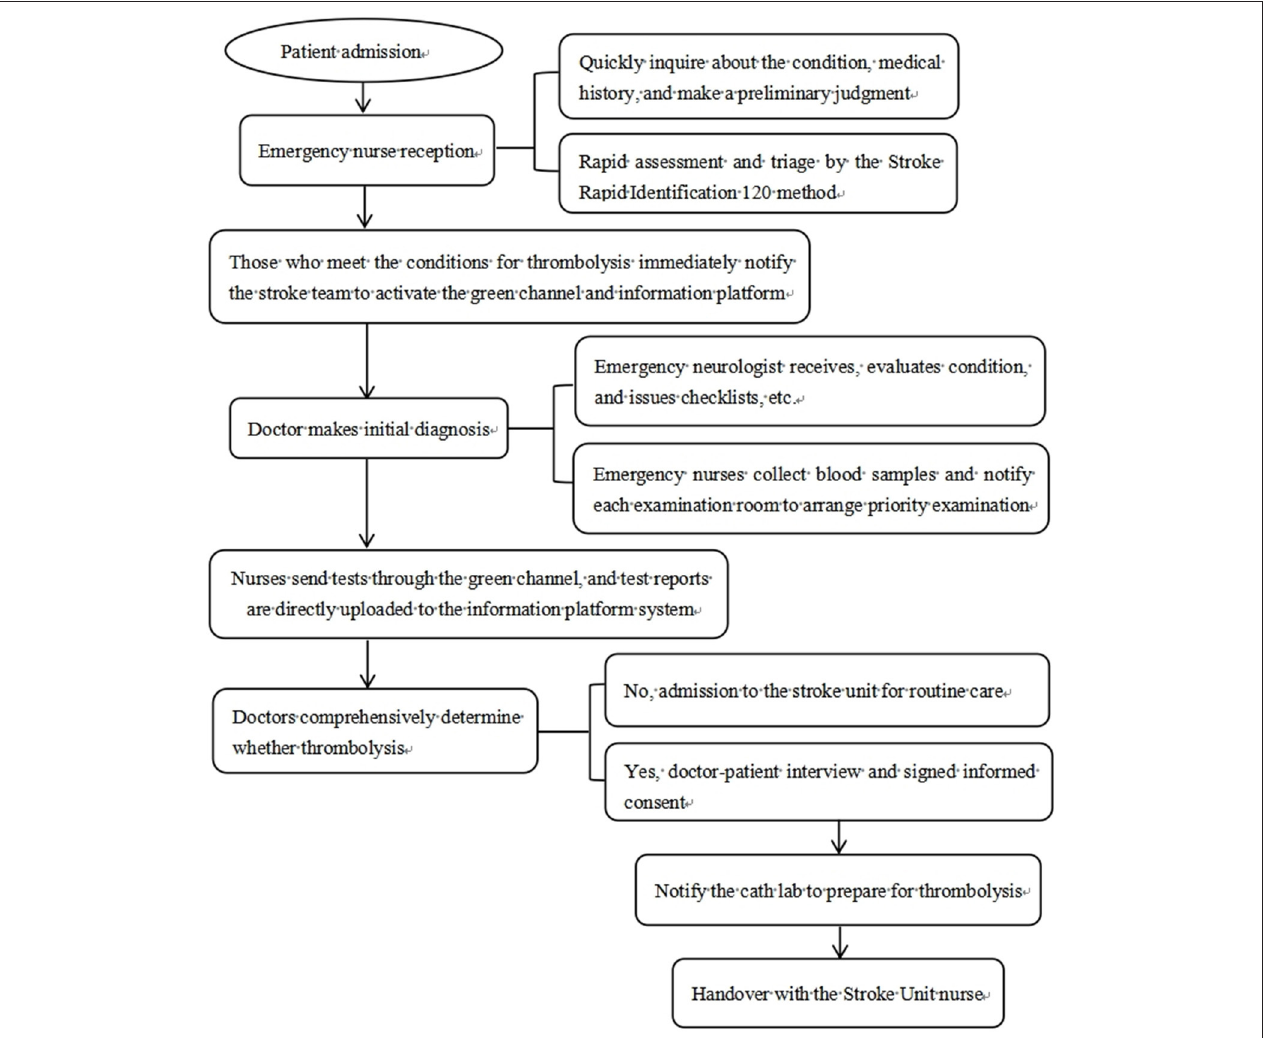
FIGURE 1 | Flow chart of the integrated emergency care model based on FMEA of AIS